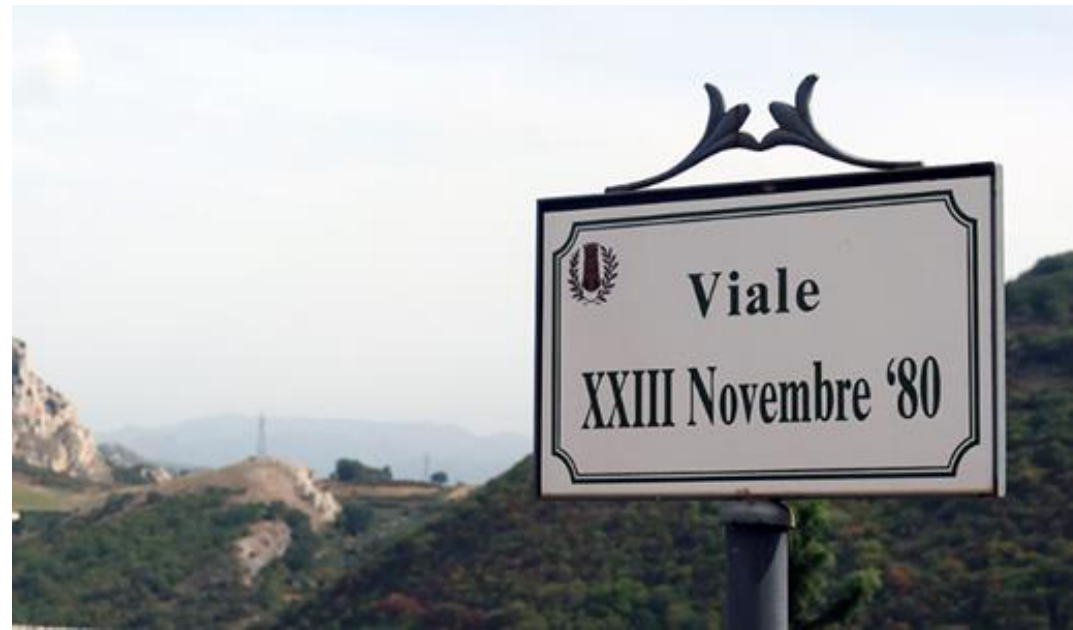
Figure 94. Salvitelle: plaque of a new street that remember the earthquake of 23 November 1980 (photos by [35,36]).